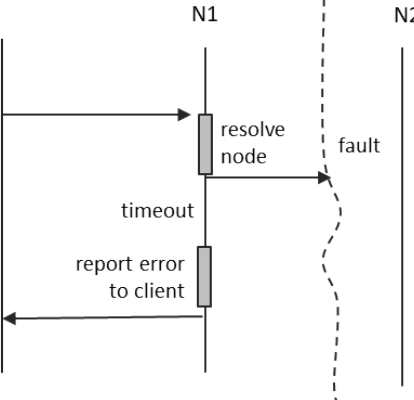
Figure 5. Notification